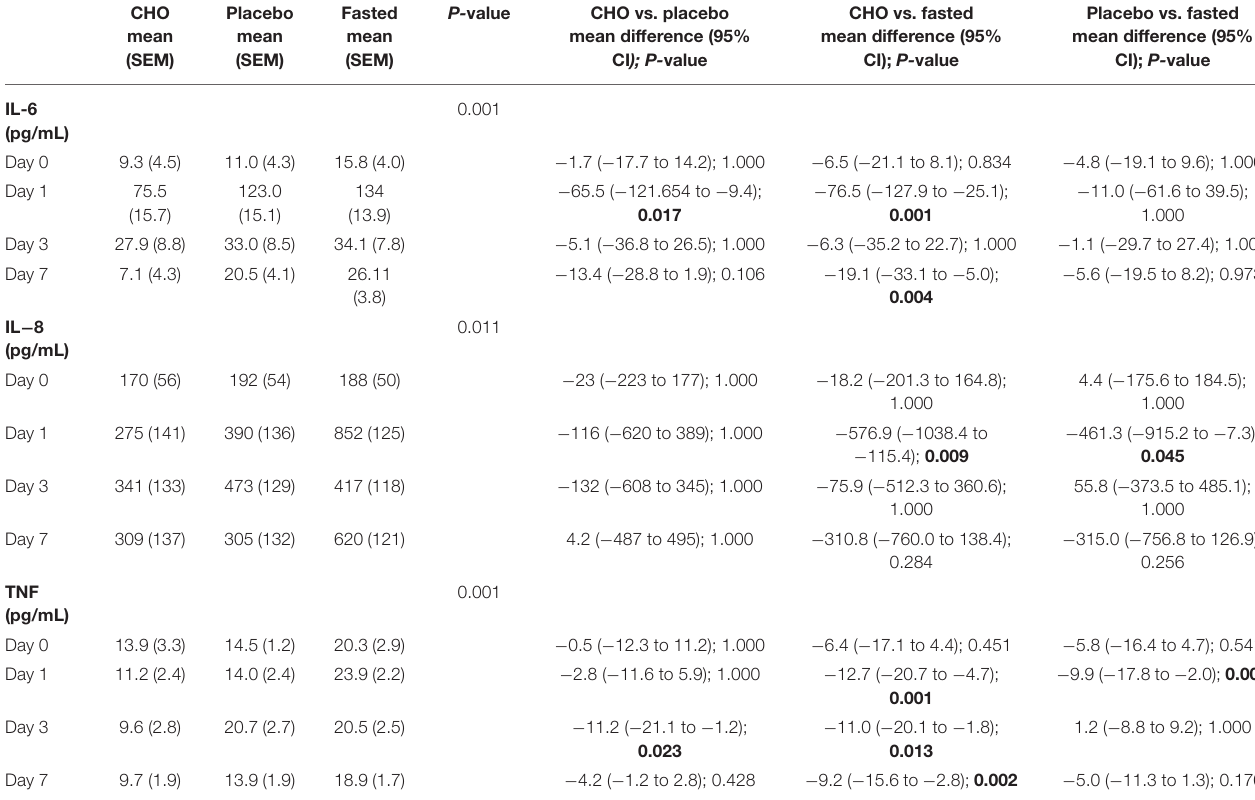
TABLE 2 | Comparison among the levels of inflammatory factors of the three groups. P- value CHO vs. placebo CHO Placebo Fasted mean mean mean mean difference (95% (SEM) (SEM) (SEM) CI ); P- value